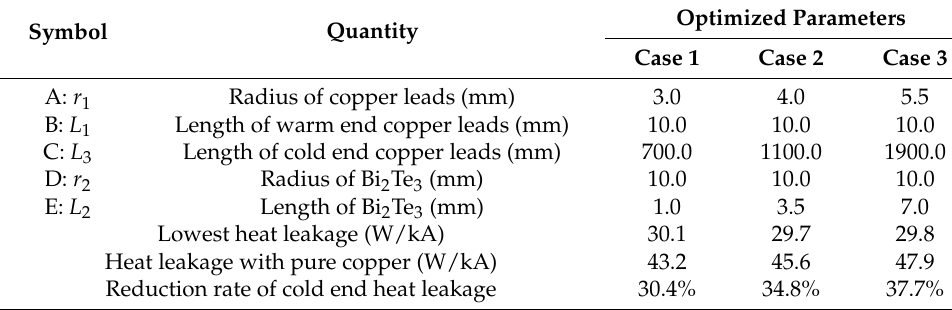
Table 3. Three sets of optimal parameters for 120 A PCLs.